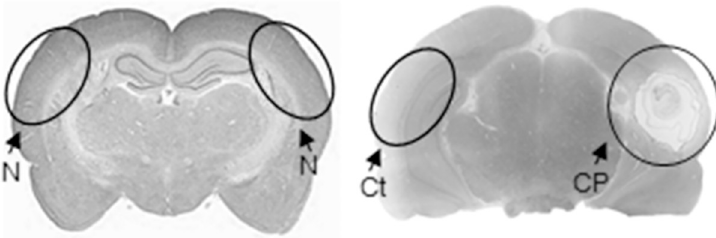
Fig 1. Tissue collected in this study. Non-infected tissue (N, n = 12), tissue close to the parasite (CP, n = 13) and, its contralateral tissue (Ct, n =